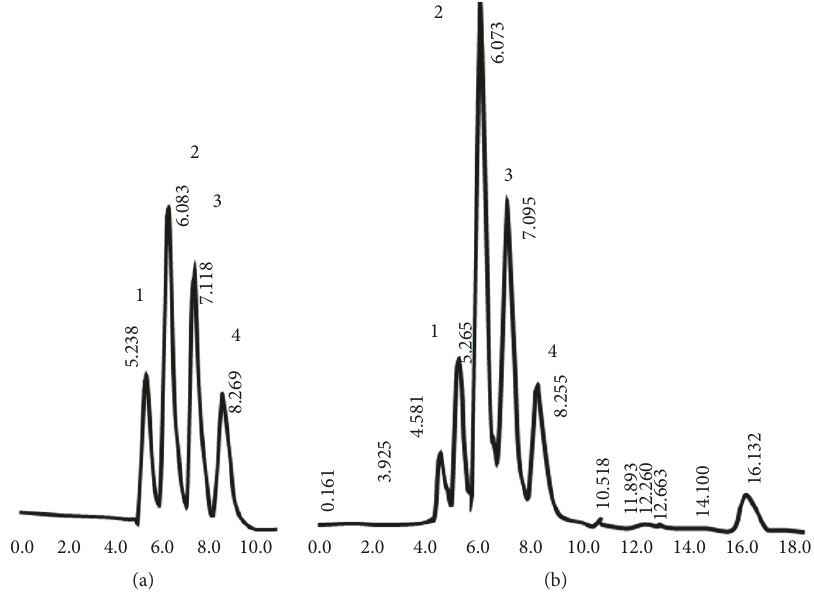
Figure 1: HPLC chromatograms of (a) standards of uric acid (75 𝜇 g/mL), creatinine (75 𝜇 g/mL), internal standard, tyrosine (125 𝜇 g/mL), and hypoxanthine (75 𝜇 g/mL). 1, uric acid (5.2 min); 2, creatinine (6.0min); 3, tyrosine the internal standard (7.1min); 4, hypoxanthine (8.2min). (b) HPLC chromatogram of human urine.